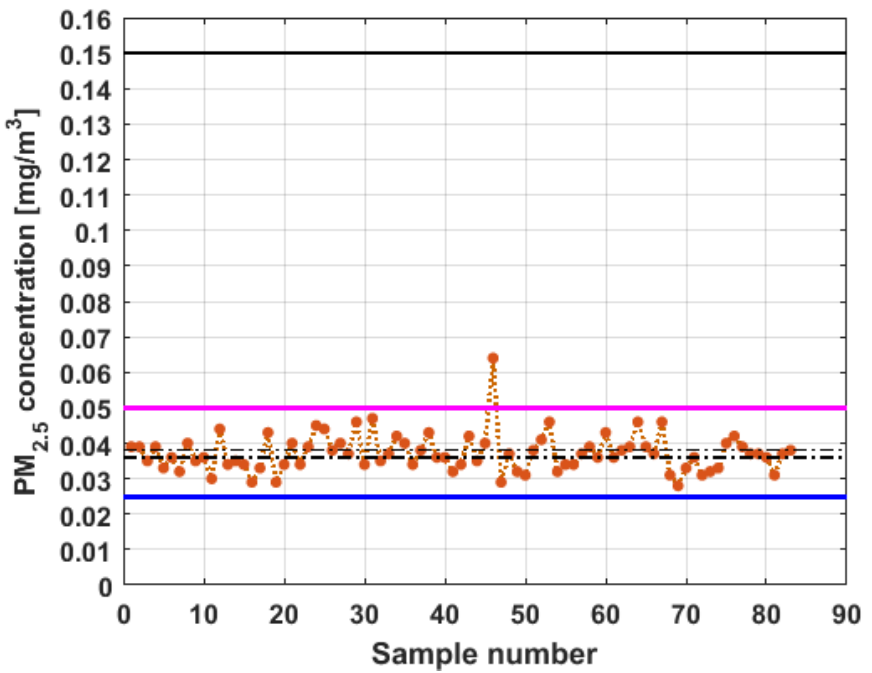
Figure 12. Observations of variable 𝑋 2 , together with the 95% nonparametric confidence interval for the median (shown with dashed black lines) and the limits that define the categories of the level of air pollution by PM 2.5 (Desirable level: Blue line; Acceptable level: Magenta line; Caution level: Black line).